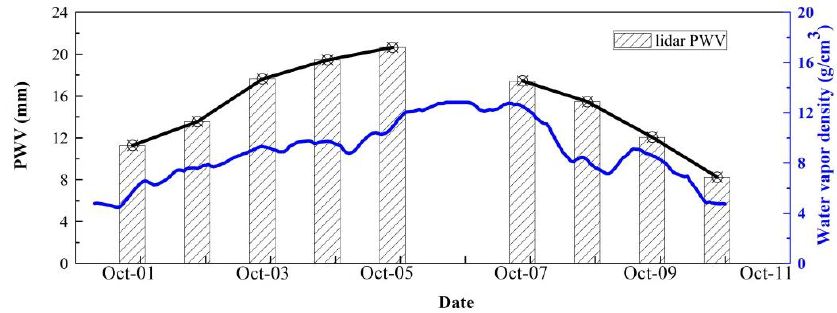
Figure 13. Time series of the lidar PWV and surface water vapour density during 1–10 October 2015. The synchronous time series of metrological parameters, including relative humidity, vapor pressure and DTD, are shown in Figure 14 a–c, and the corresponding change rates are also given. Before and after rainfall, it is clearly seen that both vapor pressure and DTD showed trends of obvious diurnal changes, with maxima at midday and minima at night. Meanwhile, the opposite diurnal trend was observed in relative humidity, with highs at night and lows at midday. However, obviously different change trends were found in these metrological parameters during the rainfall. They all showed a stable trend and less change. The relative humidity was stable and remained within a range of 80–100%. The vapor pressure and DTD were both steady and less variable. The vapor pressure was approximately 20 hPa, and DTD was less than 2 K. The corresponding change rates can also reflect the variation trend of these metrological parameters. An obvious trend in change rate can be seen for individual parameters before and after rainfall. The change rate is within the range of −3 K to +3 K per hour for DTD, in the scope of −3 hPa to +3 hPa per hour for vapor pressure, and −10 to 10% per hour for relative humidity before and after rainfall. However, these meteorological parameters are accompanied with stable trends with change rate of close to 0 in the rainfall processes. Therefore, higher and stable humidity, lower and stable vapor pressure and dew-point temperature differences were found to accompany the rainfall processes.